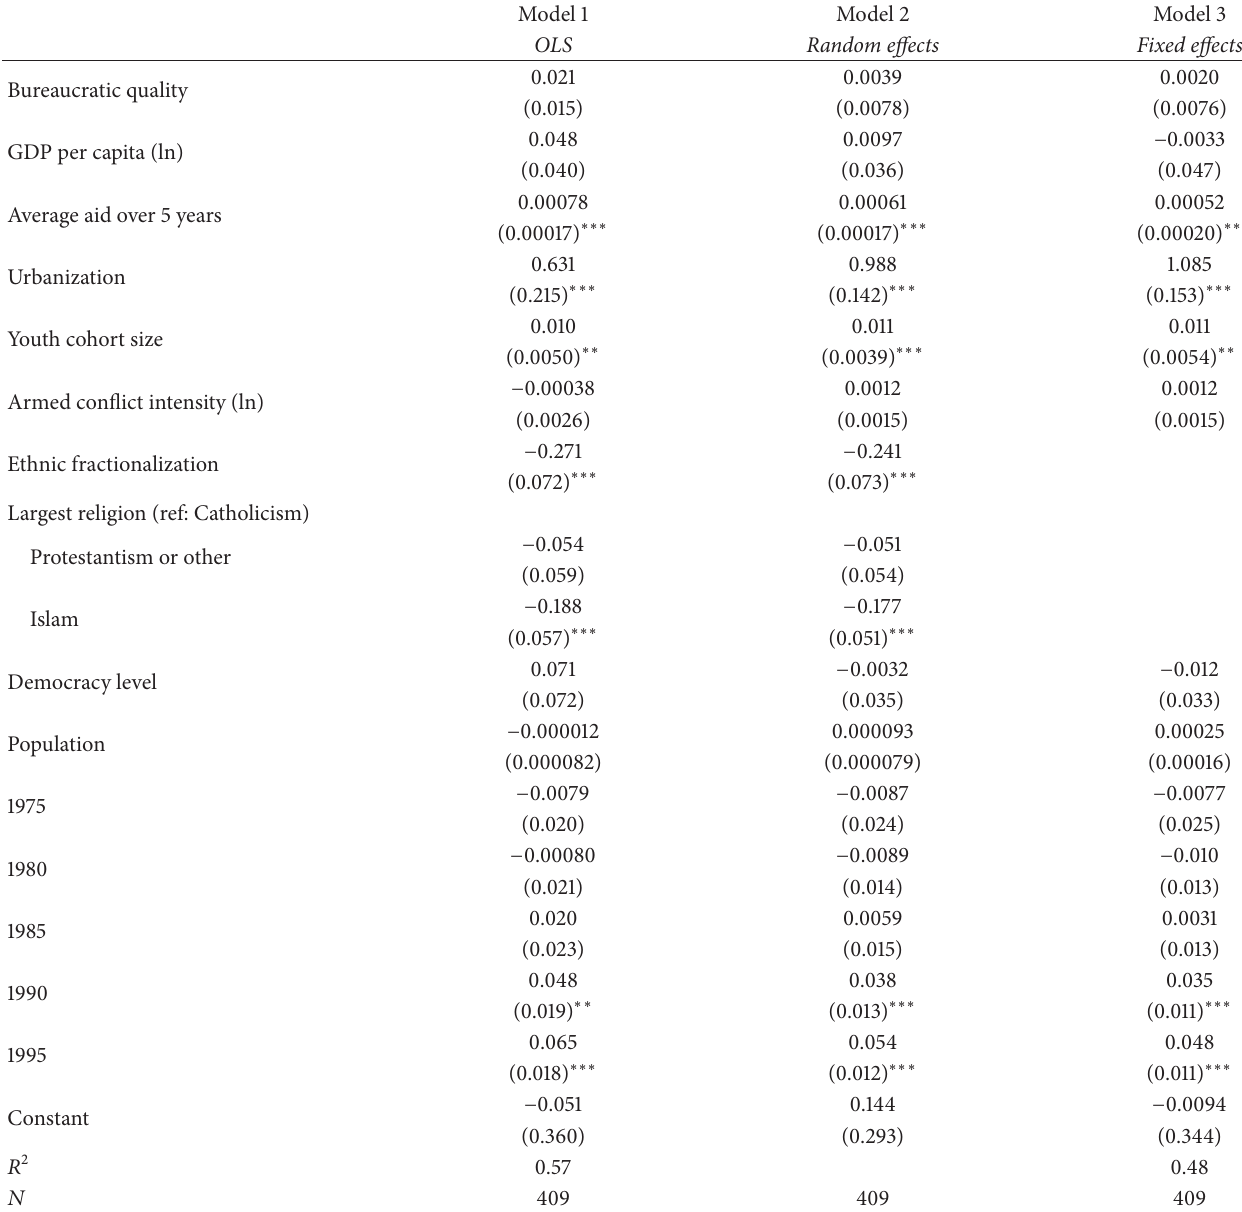
Table 4: Gender parity in secondary education attainment, developing countries: